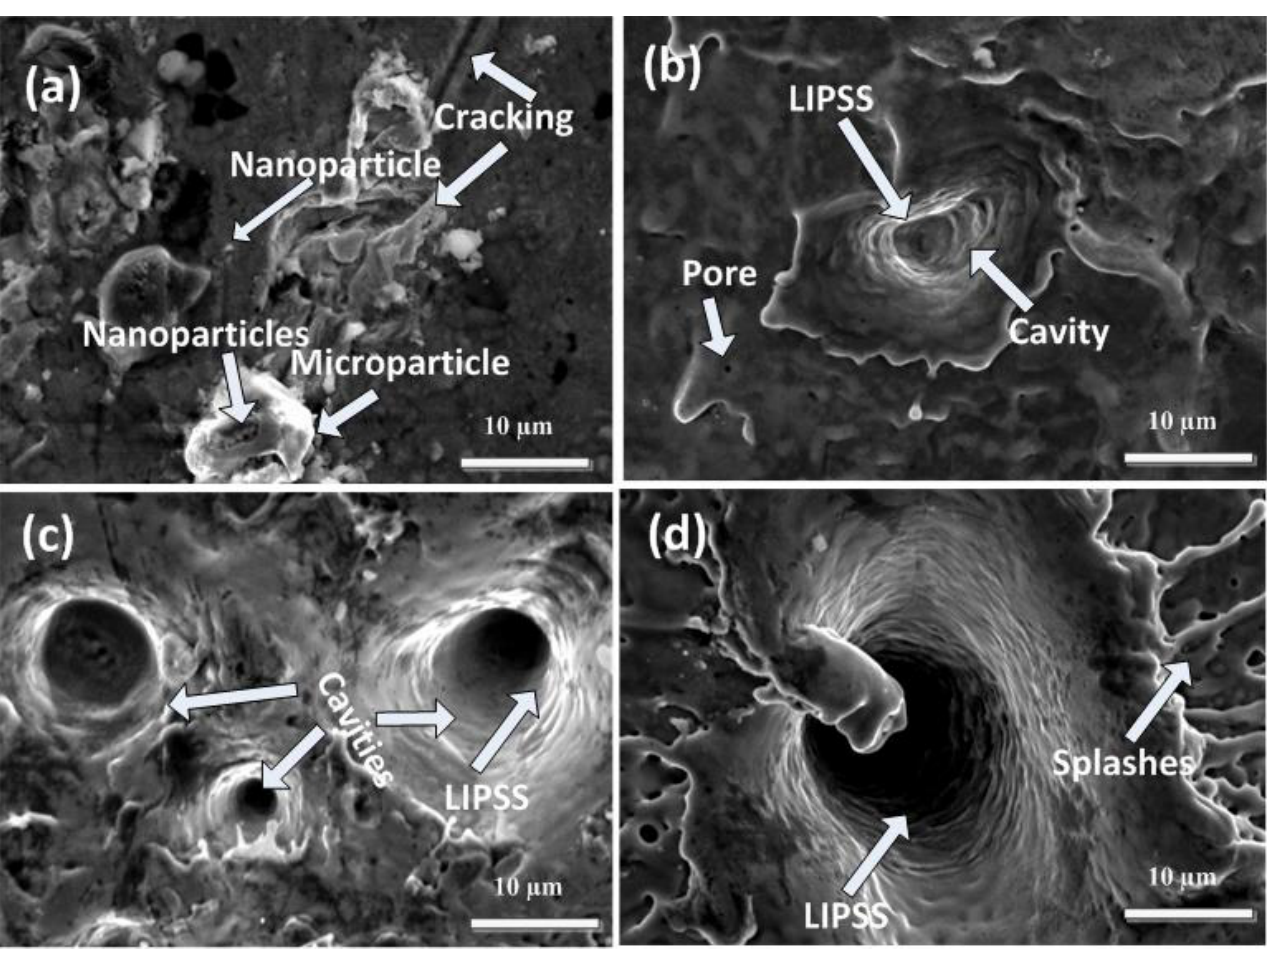
Figure 4. SEM images of peripheral ablated areas of Cd targets exposed to ( a ) 500, ( b ) 1000, ( c ) 1500, and ( d ) 2000 laser pulses at a constant fluence value of 3.6 Jcm − 2 in ethanol. and ( d ) 2000 laser pulses at a constant fluence value of 3.6 Jcm − 2 in For 2000 pulses, along with a reduction in crater density, a large-sized crater with a diameter of 15.7 µm is observed. A cone with an enhanced diameter of 5.7 µm along with